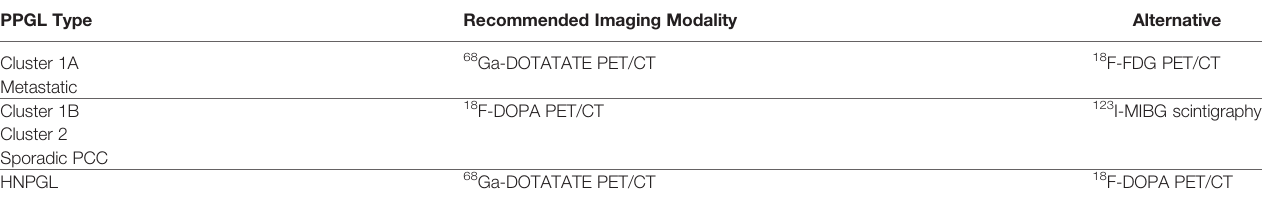
TABLE 3 | Functional imaging recommendations for pediatric